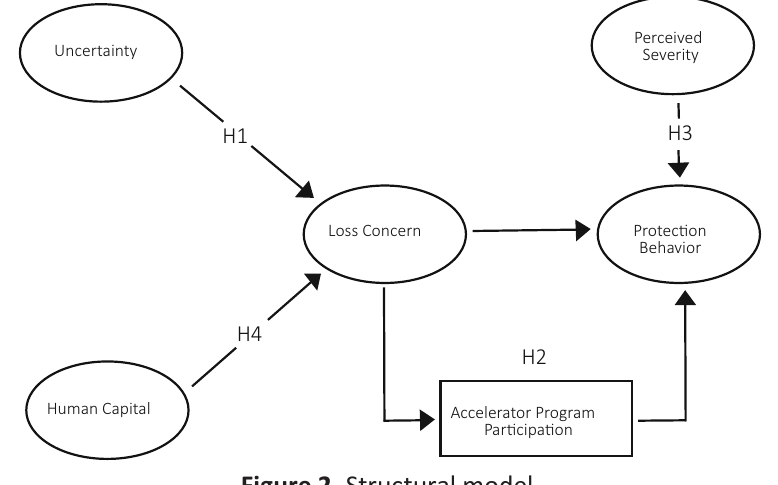
Figure 2. Structural